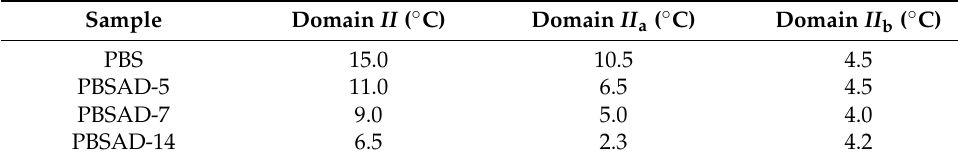
Table 4. The temperature ranges of domains II , II a , and II b of PBS and